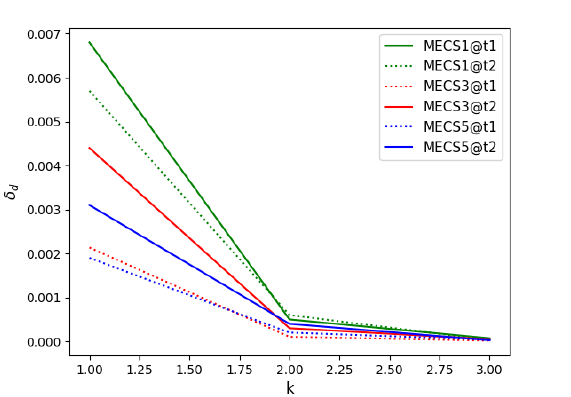
Figure 2. Convergence property of the Delta activation level (the time slots t 1 and t 2 are randomly selected and t 1 (cid:54) = t